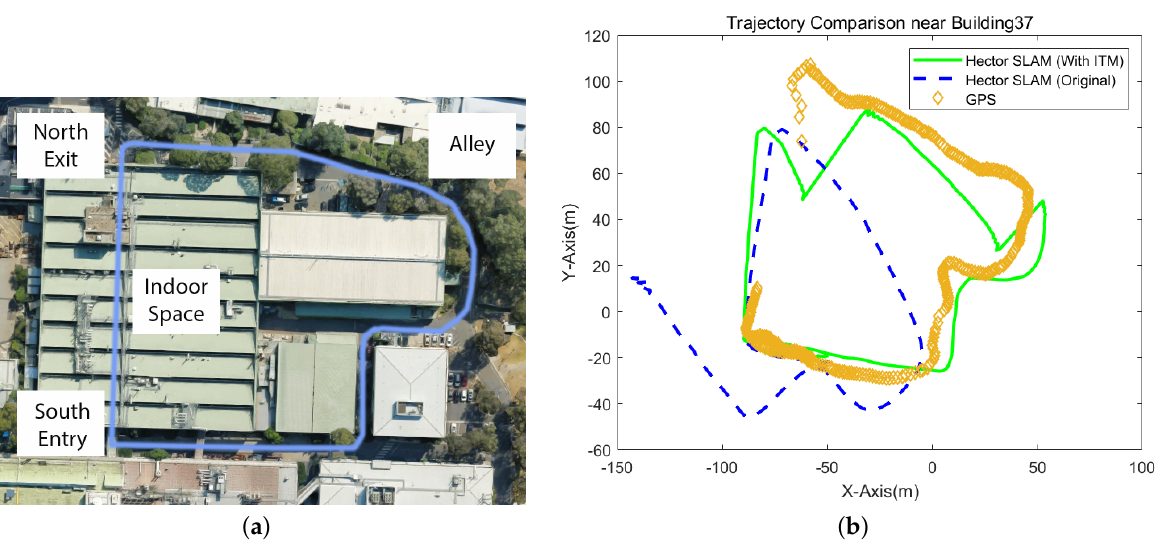
Figure 8. Experiment around Building 37 with Trajectories. ( a ) Satellite photo of Building 37 with trail highlighted. ( b ) Trajectories compared in the Building 37